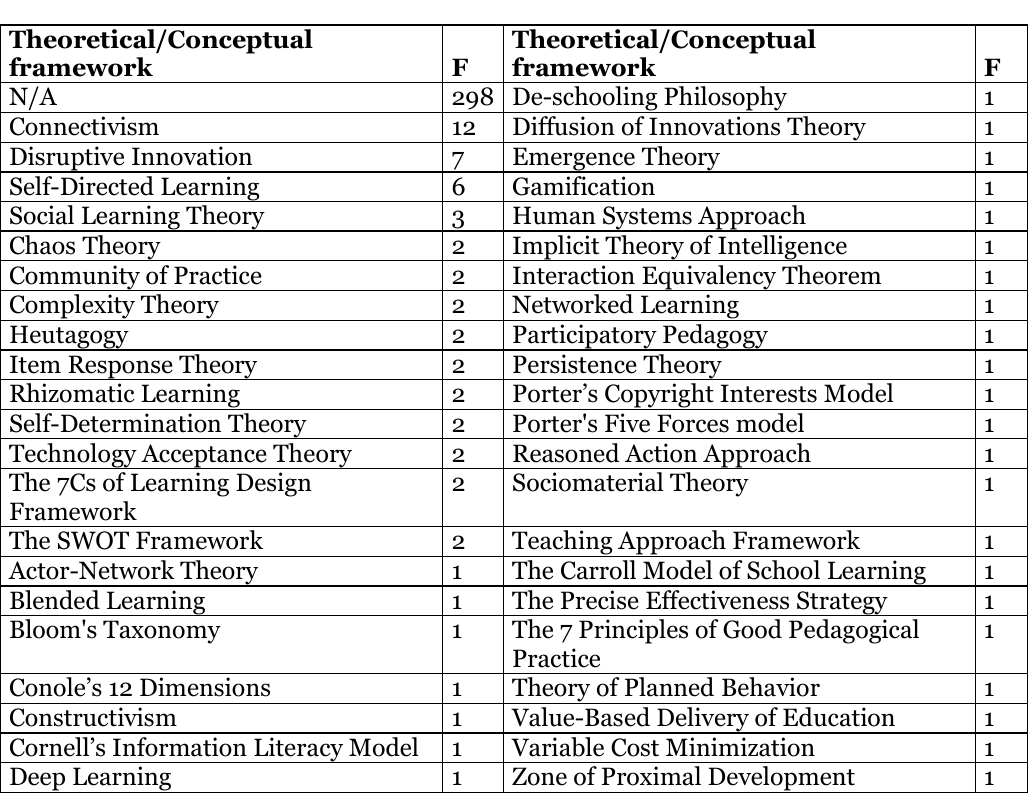
Table 3 Description of Research Theoretical/Conceptual Frameworks